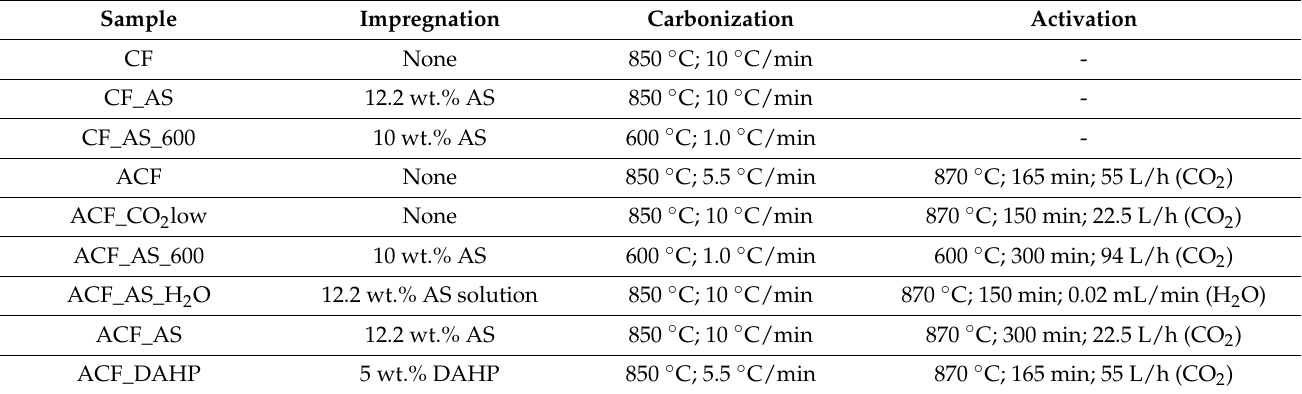
Table 1. The description of the material synthesis and activation